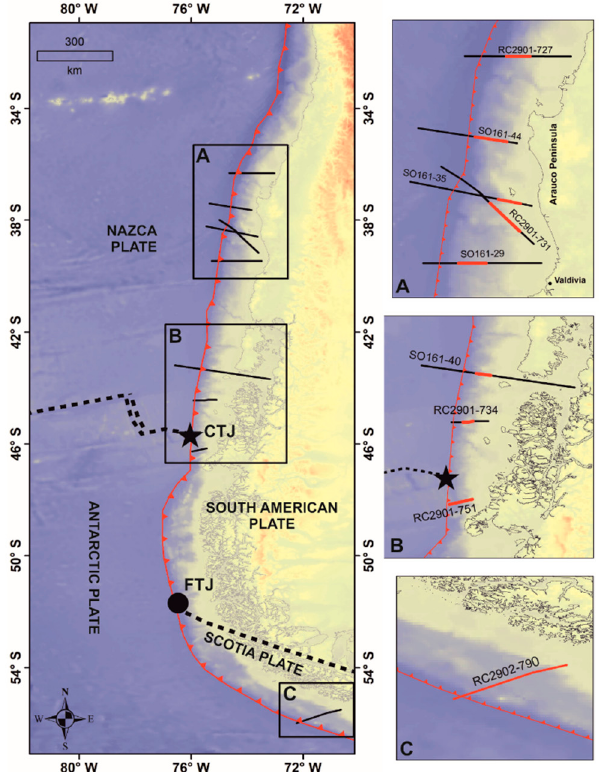
Figure 1. Map of the investigated area. Black lines: analyzed seismic lines. Black rectangles: the location of the A , B , and C panels. Black star: CTJ. Black Dot: FTJ. Dashed Lines: division between plates. Red Line: Outer deformation front. In the panels A , B and C , the red lines indicate the portion of the seismic lines that were analyzed.